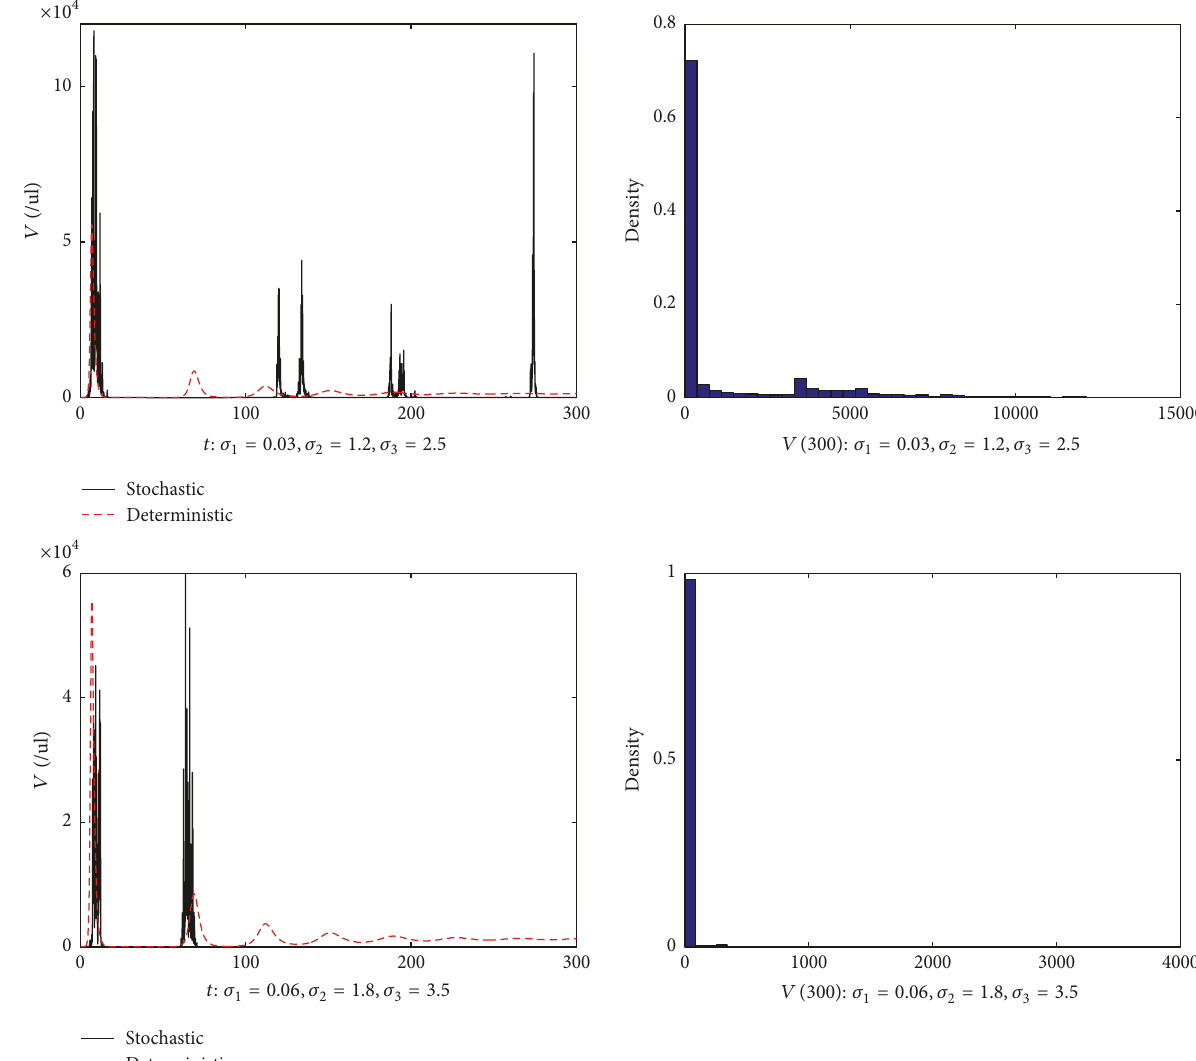
Figure 3: The paths of 𝑉(𝑡) for stochastic model (3) and the solutions of 𝑉(𝑡) for its corresponding deterministic model (1) with (𝜎 1 ,𝜎 2 ,𝜎 3 ) equal to (0.03, 1.2, 2.5) and (0.06, 1.8, 3.5) ,